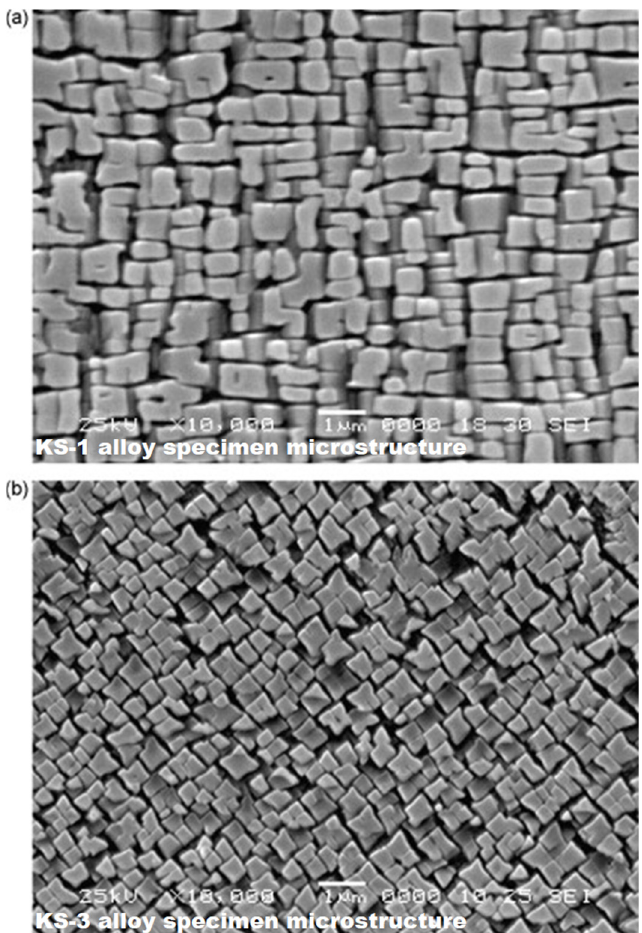
Figure 2. Coherent γ - γ ’ microstructures of the KS-1 ( a ) and KS-3 ( b ) alloys specimens were producing via complete heat treatment included hot isostatic pressing (HIP), homogenization and two-step aging. Copyright 2008 Elsevier.